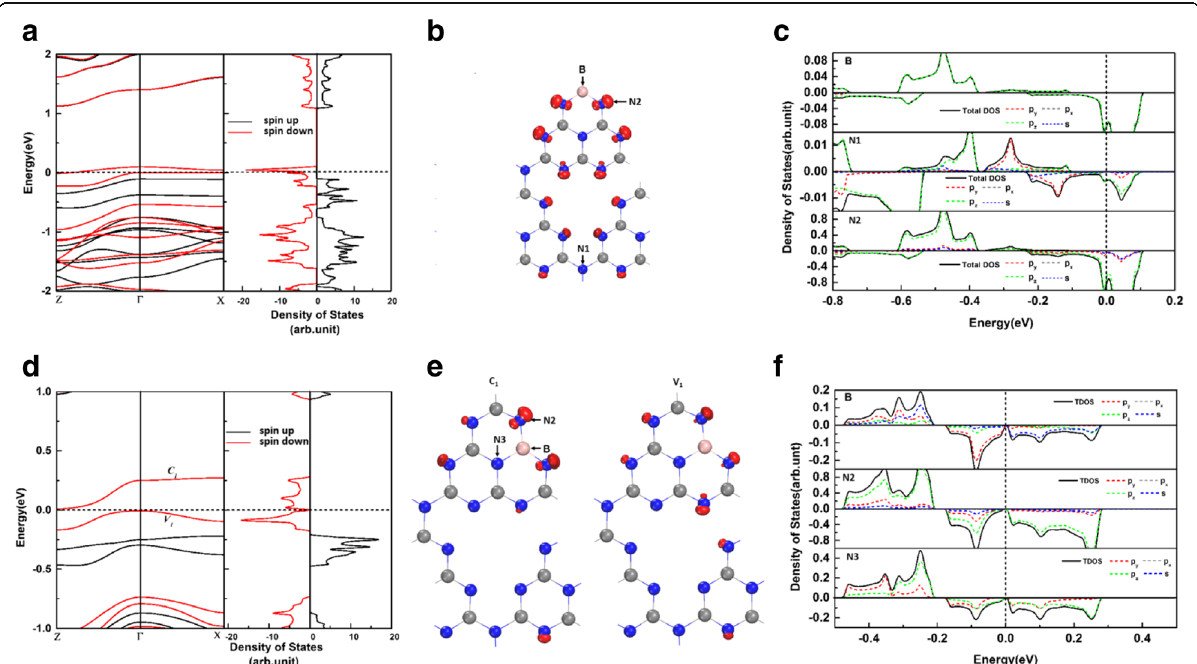
Fig. 3 a The spin-dependent band structure and the total density of states of B C1 @gh-C 3 N 4 . b The charge densities of the two bands crossing the Fermi level. c The orbital-resolved electron density of states projected onto B atom, N1 atom, and N2 atom (indexed in b ) for B C1 @gh-C 3 N 4 . d – f are the same with a – c but for B C2 @gh-C 3 N 4 . The energy at the Fermi level is set to zero